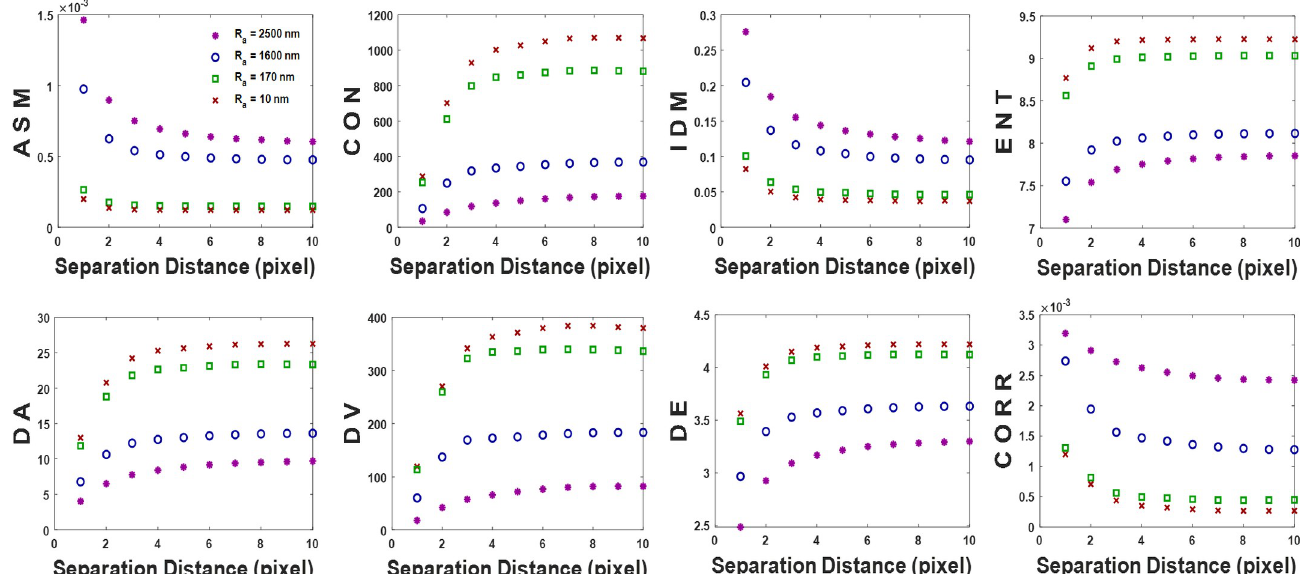
Fig 6. Plots of the extracted Haralick’s statistical parameters from the GLCM of four biospeckle images along 0˚ direction versus the separation distance.